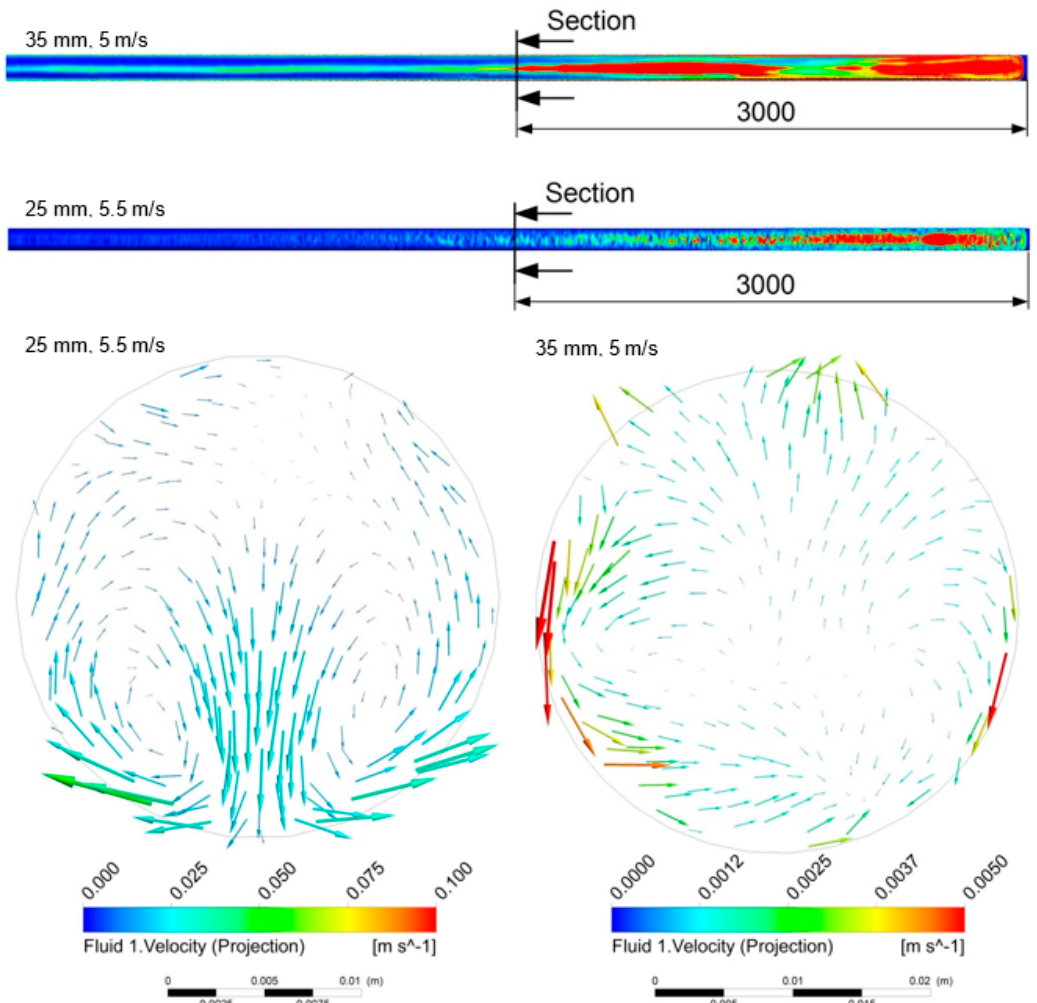
Figure 10. Projection of a vector field at a plane perpendicular to the pipe axis at a distance of 3 m from the inlet of the pipe. On the left, there is a 25 mm diameter pipe at a speed of 5.5 m / s; on the right-hand side, a pipe with a diameter of 35 mm is displayed at a speed of 5 m / s.